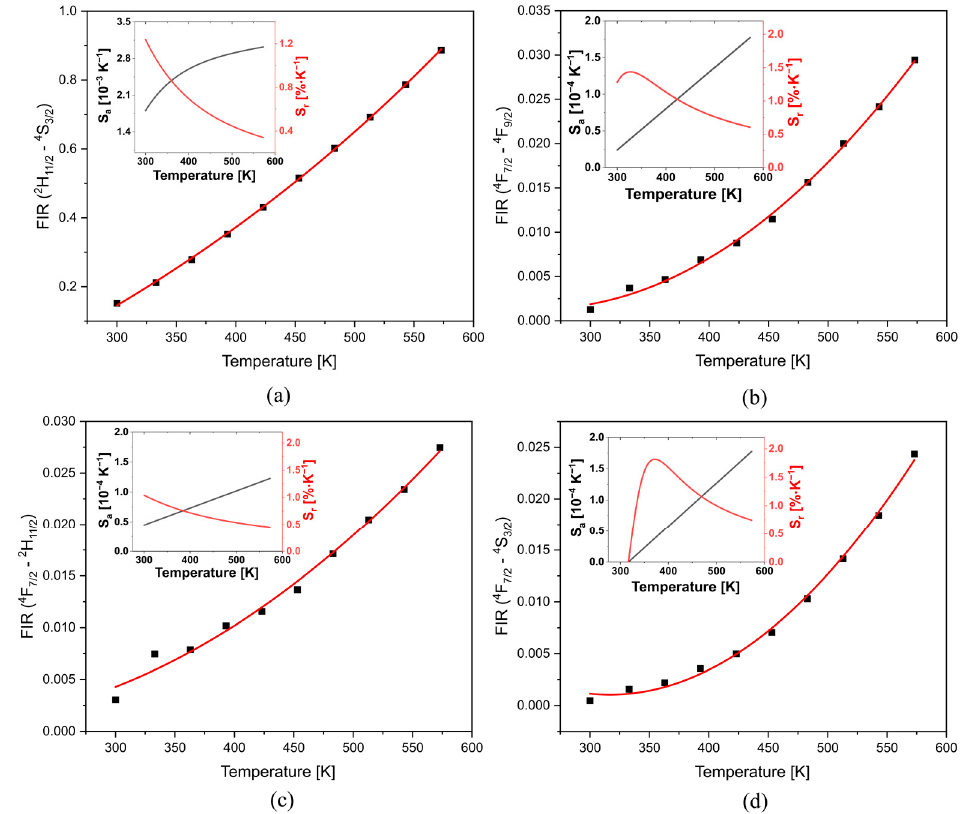
Figure 3. The FIR of ( a ) TCLs ( 2 H 11/2—4 S 3/2 ); ( b ) non ‐ TCLs ( 4 F 7/2—7 F 9/2 ); ( c ) non ‐ TCL—TCL ( 4 F 7/2—2 H 11/2 ); ( d ) non ‐ TCL—TCL ( 4 F 7/2—4 S 3/2 ); Insets show the absolute and relative sensitivity.